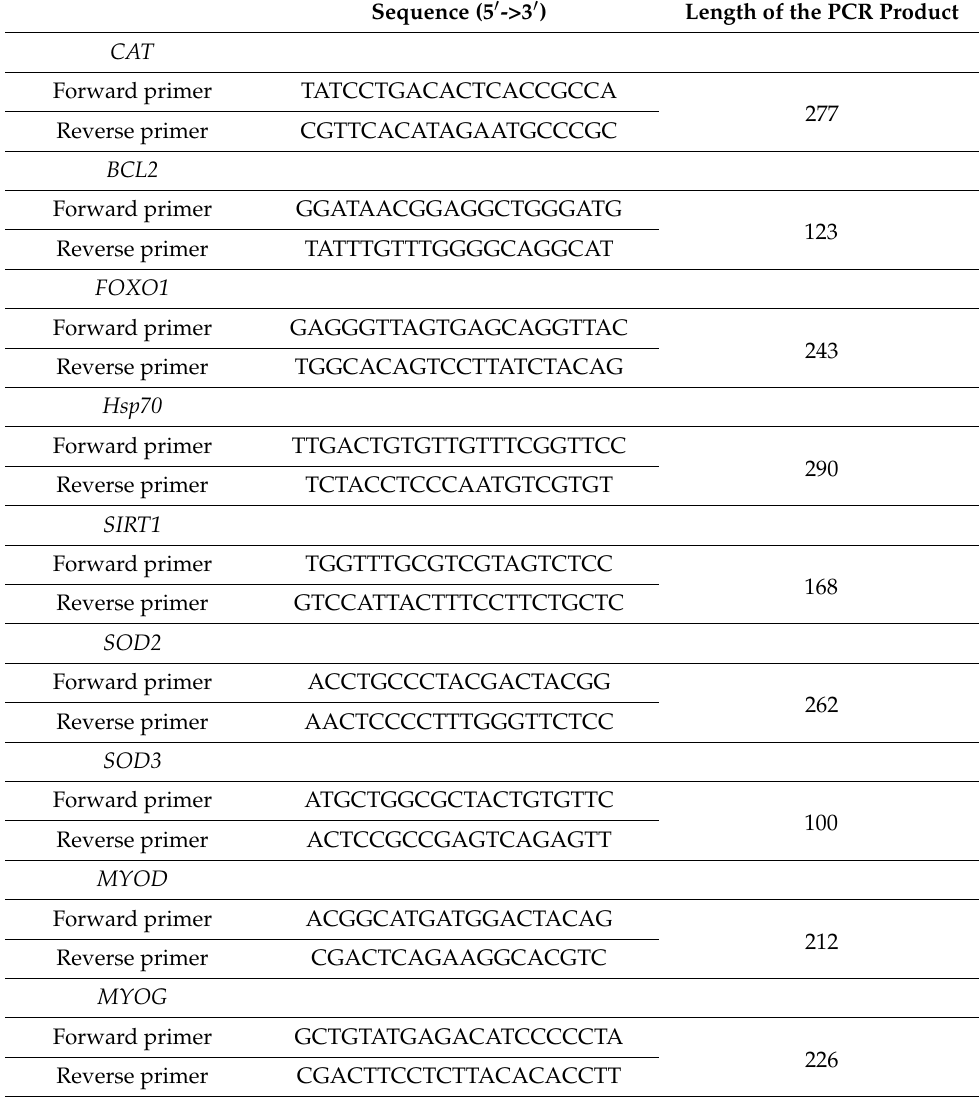
Table 1. Primer sequences and the expected lengths of synthesis products. Sequence (5 (cid:48) ->3 (cid:48)